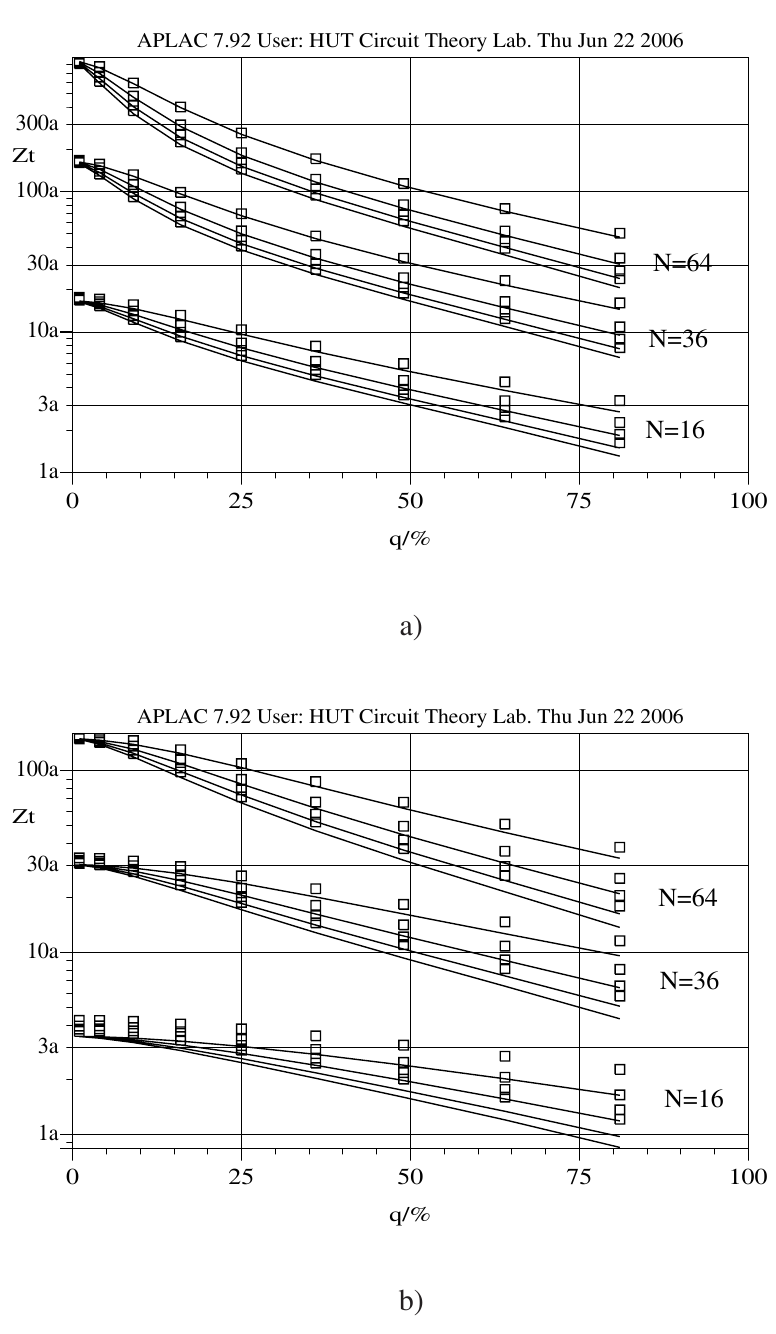
Figure 7 . Damping coef fi cients of the perforated dampers in torsional motion simulated with the full 3D N-S solver ( ) and with the PPR solver (——) as a function of the perforation ratio. N is 16 , 36 , and 64 , (cid:0) and the damper height h is 0.5 µ m, 1 µ m, 2 µ m, and 5 µ m. The air gap height is a) 1 µ m and b) 2 µ c